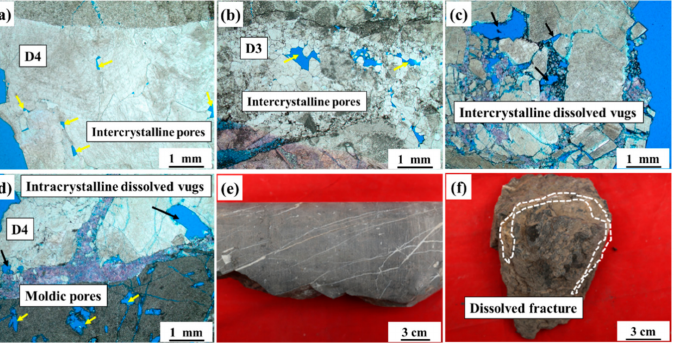
Figure 6. The reservoir space characteristics of the dolomite reservoir in the Dongying Depression, Bohai Bay Basin. ( a ) The intercrystalline pores (yellow arrow) between the saddle dolomites (D4), Well Bg22 2246.89 m, Ordovician formation, plane-polarized light; ( b ) the intercrystalline pores (yellow arrow) between the medium-to-coarse-crystalline dolomite cements, Well Bg26 2793.2 m, Zhangxia formation, plane-polarized light; ( c ) intercrystalline-dissolved vugs (black arrow) between the saddle dolomites (D4), Well Bg22 2236.4 m, Ordovician formation, plane-polarized light; ( d ) intracrystalline dissolved vugs (black arrow) within the saddle dolomites (D4), Well Bg22 2233.04 m, Ordovician formation, plane-polarized light; ( e ) microcrystalline dolomite (M2) high-angle structural fractures, Well Bg22 2348.4 m, Ordovician formation, core; ( f ) microcrystalline dolomite (M2), dissolved fractures (white dotted line), the saddle dolomites fill in the fracture, Well Bg22 2235.84 m, Ordovician formation,